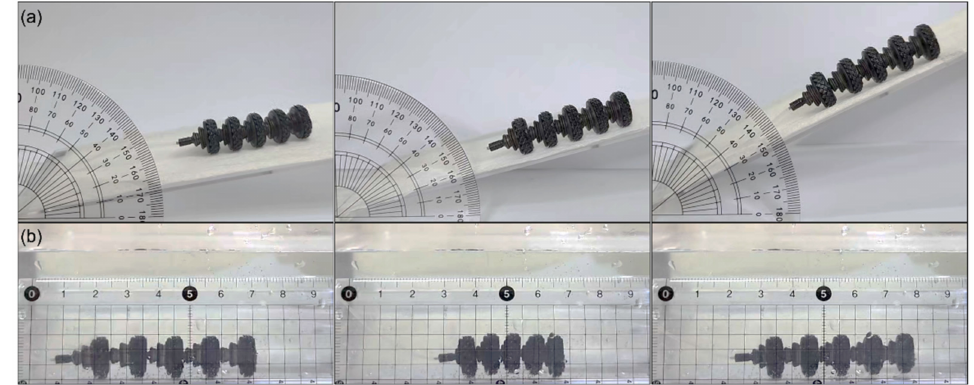
Figure 8. Locomotion of MSSR under different conditions. ( a ) Demonstration of movement along the slope of the paper tower surface. ( b ) Captured pictures according to the operating cycle of the MSSR under